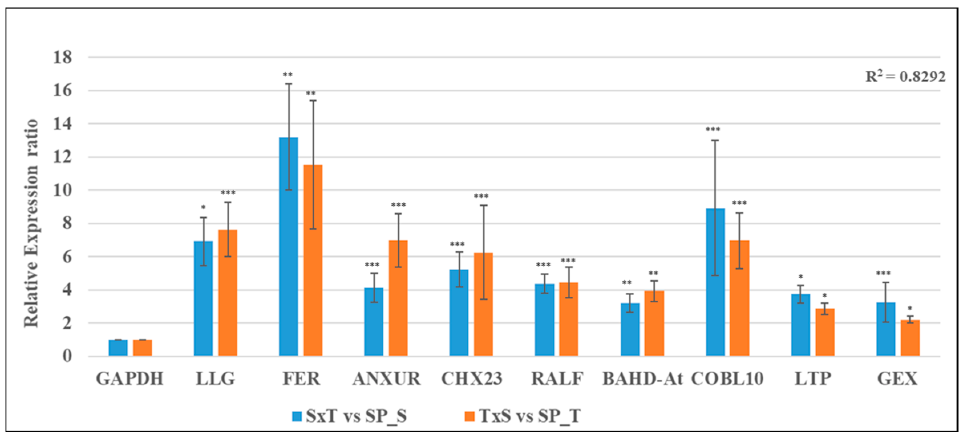
Figure 5. Relative expression analysis depicting strong positive correlation of reciprocal crosses (SxT & TxS) in CP pistils using GAPDH as internal control having strong positive correlation ( R 2 = 0.8292) between them. The bar represents SD of relative expression for three replicated experiments, significance level is represented as symbols (“***”, “**”, “*”) <=> p -values (0.001, 0.01, 0.05).